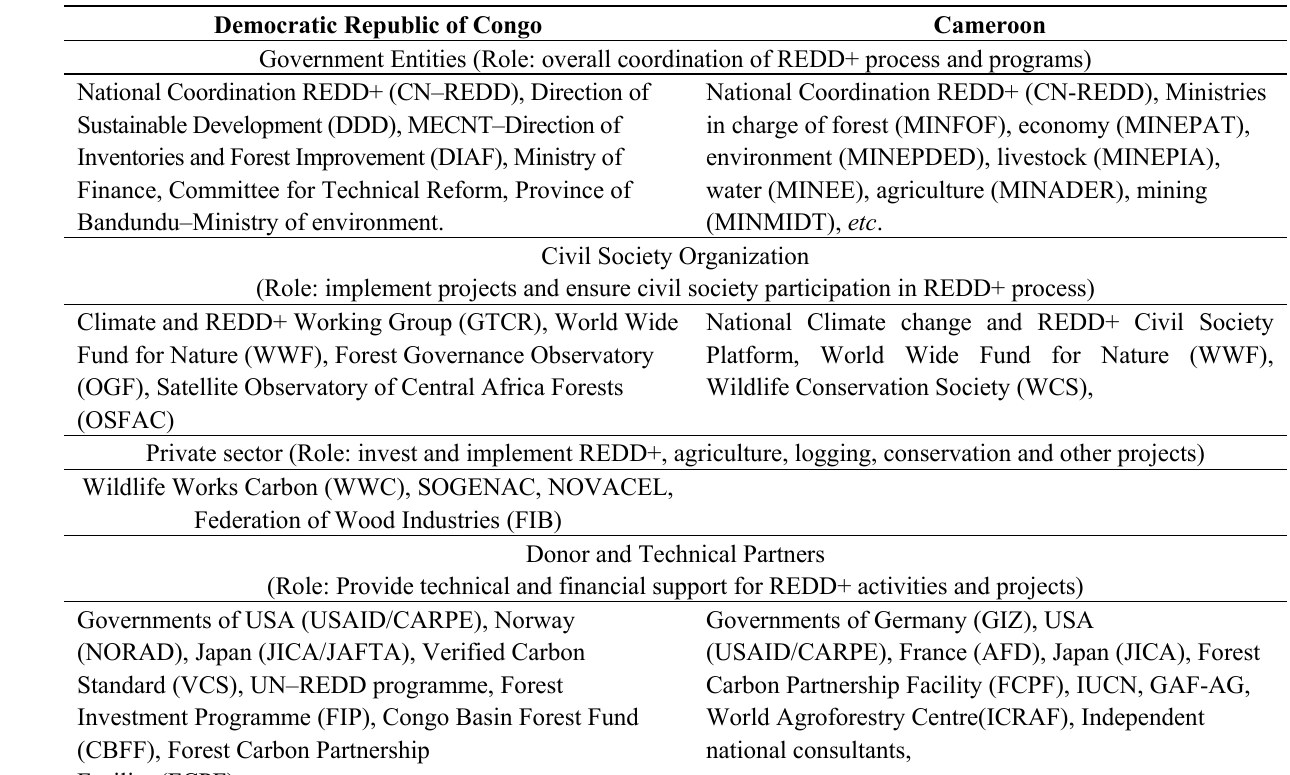
Table 1. Key stakeholders involved in the REDD+ process in the Democratic Republic of Congo (DRC) and